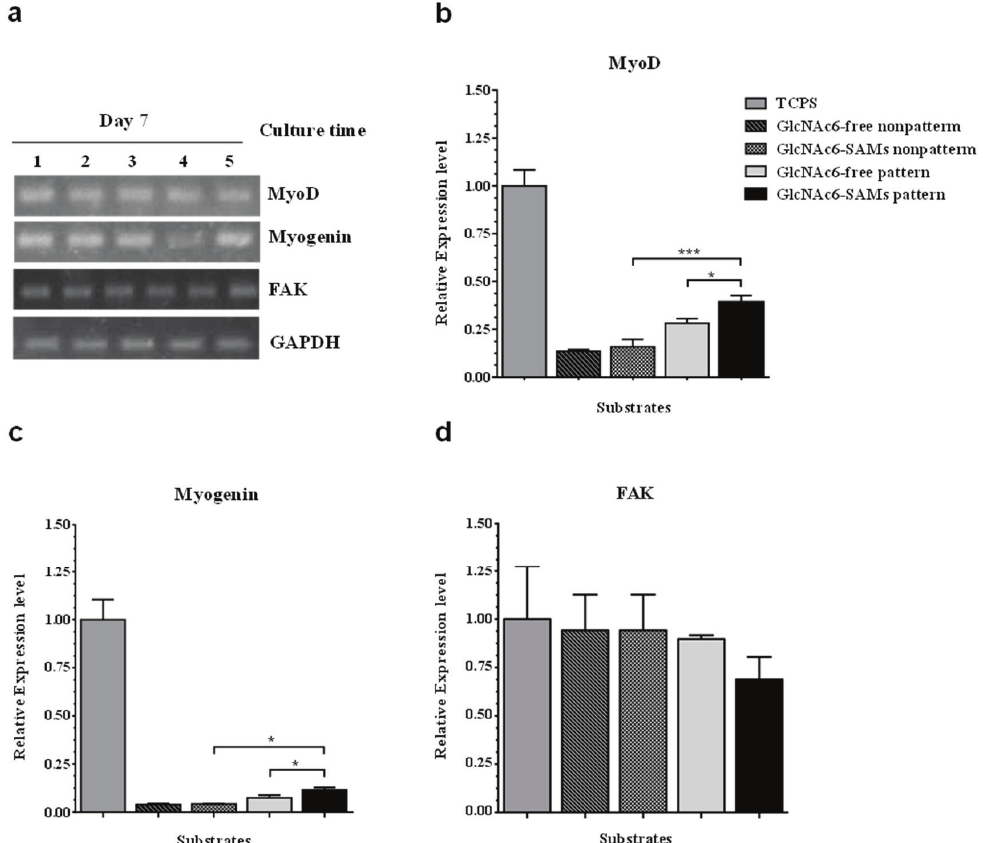
Figure 6. Comparison of gene expression on micropatterns with and without GlcNAc6-SAMs after seven days’ culture. The regulation of myogenin genes in myoblast C2C12 cells was detected using RT-PCR. ( a ) PCR products were analyzed on a 2% agarose gel by ethidium bromide staining. Band intensities are presented, normalized to GAPDH. Lane 1, TCPS; Lane 2, GlcNAc6-free nonpatterns; Lane 3, GlcNAc6-SAMs nonpatterns; Lane 4, GlcNAc6-free pattern (500 μm); Lane 5, GlcNAc6-SAMs pattern (500 μm); ( b – d ) Individual mRNA expression profiles in myoblast C2C12 cells on the different substrates.